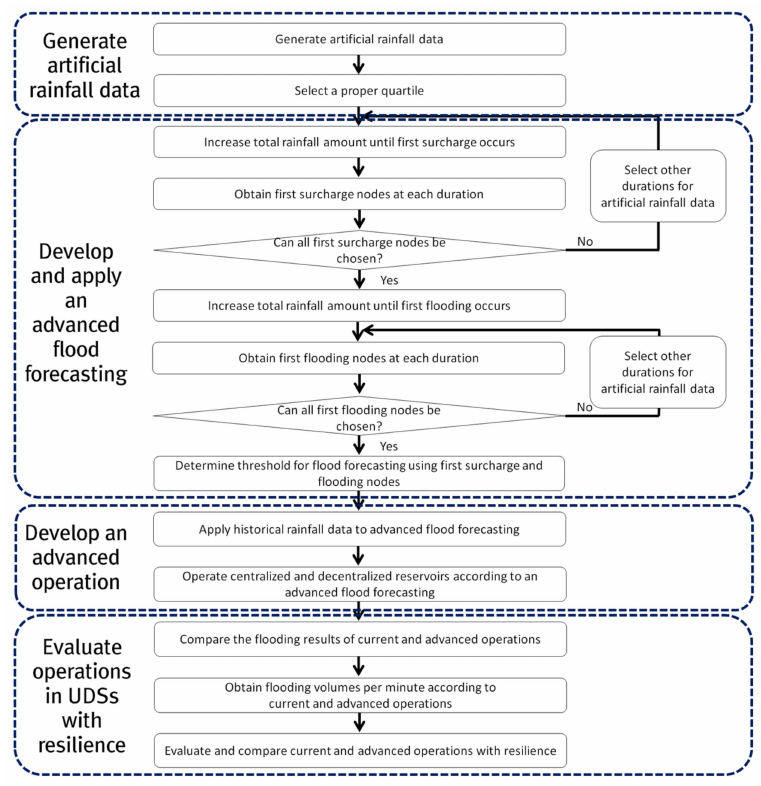
Figure 1. Flow of this